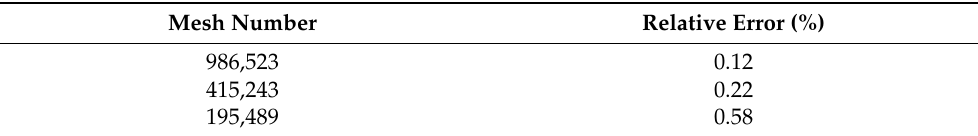
Table 1. Mesh independence test.